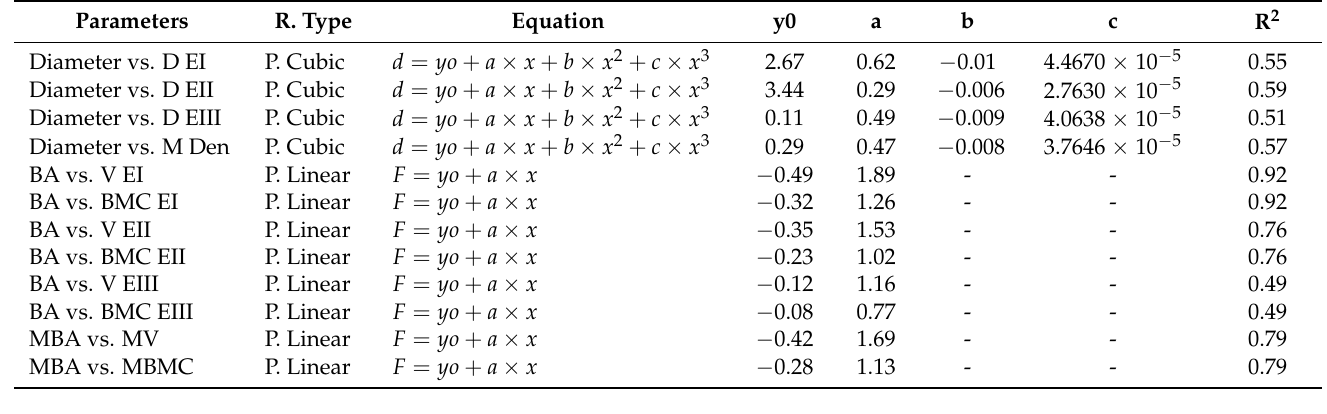
Table 5. Regression equation explaining the relation of different parameters.